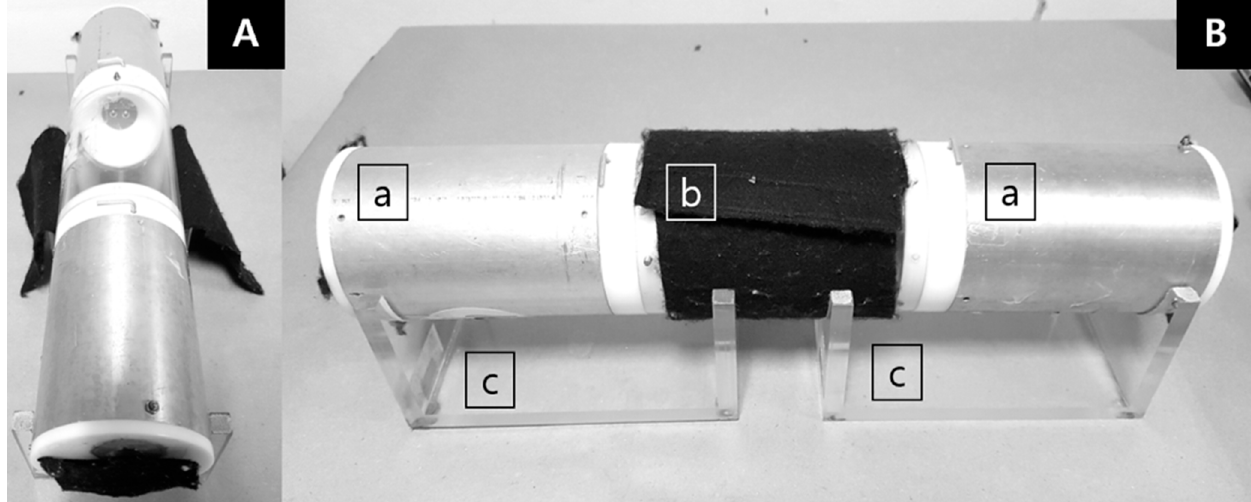
Figure 1. High-throughput screening system (HITSS) for spatial repellency assay (SRA) was applied to evaluate dose– response attraction of BG-lure. ( A ) Front view with uncovered middle cylinder and felt-covered end view window for each chamber. ( B ) Side view with felt-covered middle chamber; a: treated and untreated chambers, b: fabric covered clear cylinder, c: HITSS cradles.